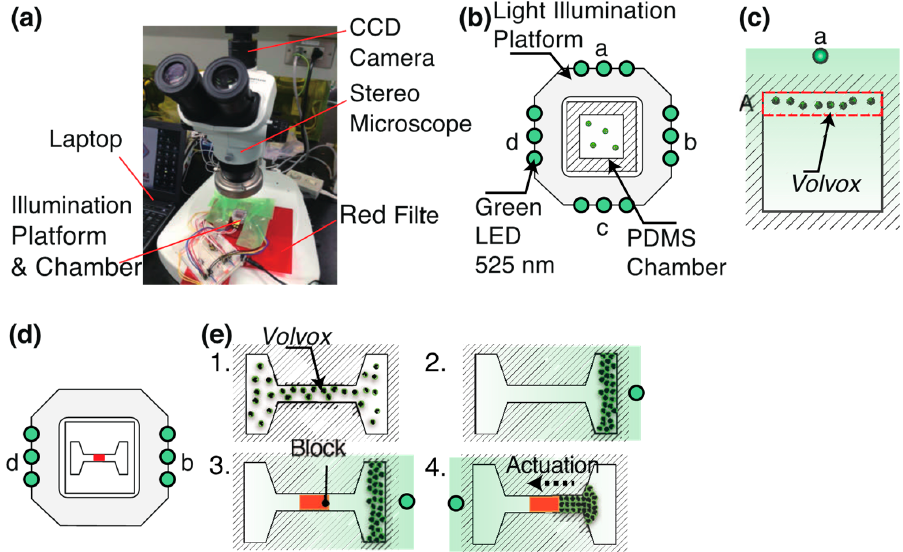
Figure 1. Experimental methods for the demonstration of ( b ), ( c ) phototactic control and ( d ), ( e ) unidirectional transport. ( a ) Picture of an experimental setup. ( b ), ( d ) schematic of the experimental setup. ( c ) Phototactic migration of Volvox to region A with LED a . ( e ) Experimental processes for the actuation of a movable block by V. carteri .